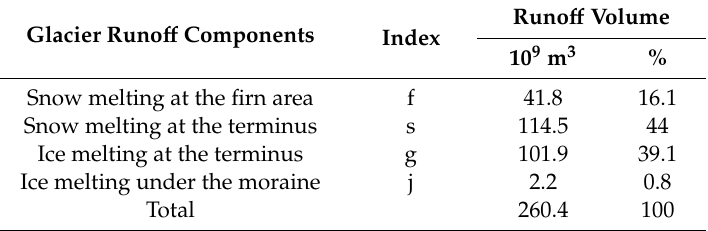
Table 3. Average value of glacier runo ff components at the northern slope of the Ile Alatau [70].